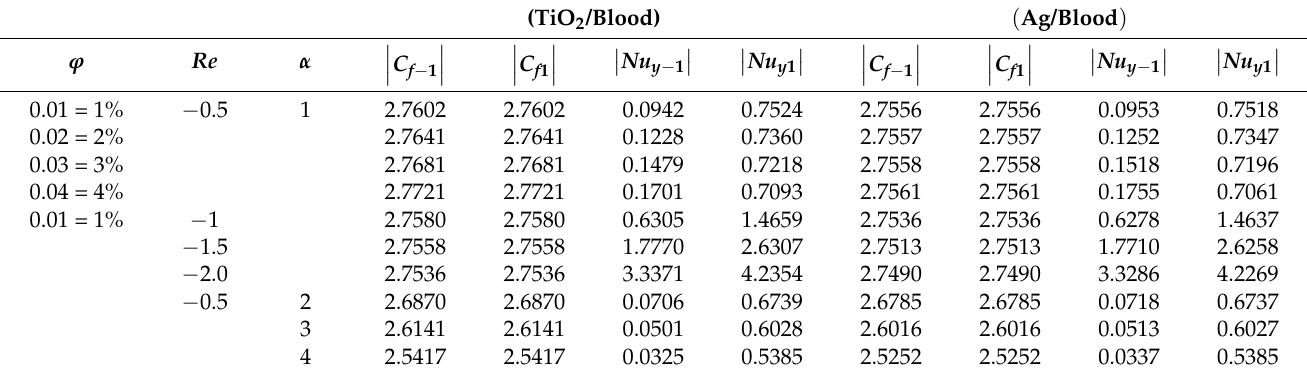
Table 4. Skin fraction and Nusselt number results on volume fraction, Reynolds number, and expansion- contraction ratio parameter for Pr = 0.1, M = 9, Nt = Nb = 0.5, Br = 0.1, β = 0.1, h = 2, r = 1.5 on different types of nanofluids.